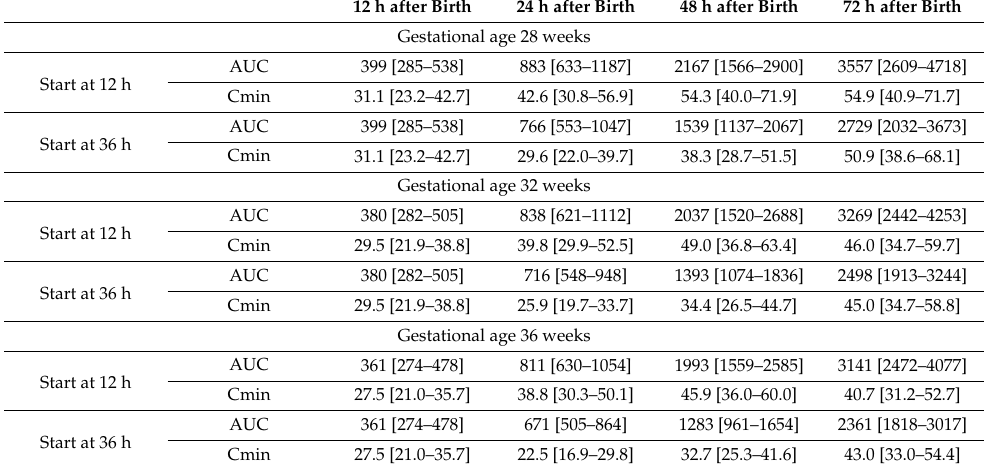
Table 2. Overview of predicted cumulative area under the concentration-time curve (AUC) and predicted plasma concentration (assessed as Cmin) during the first 72 h after birth for three different gestational age groups. Applying van Donge et al. dosing regimen [10]. 12 h after Birth 24 h after Birth 48 h after